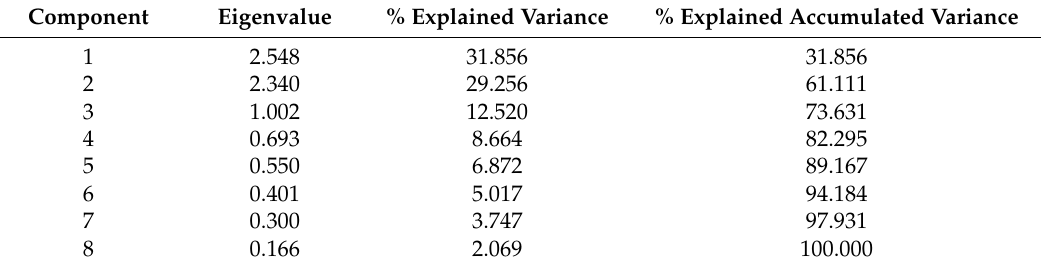
Table 5. Eigenvalues and variance